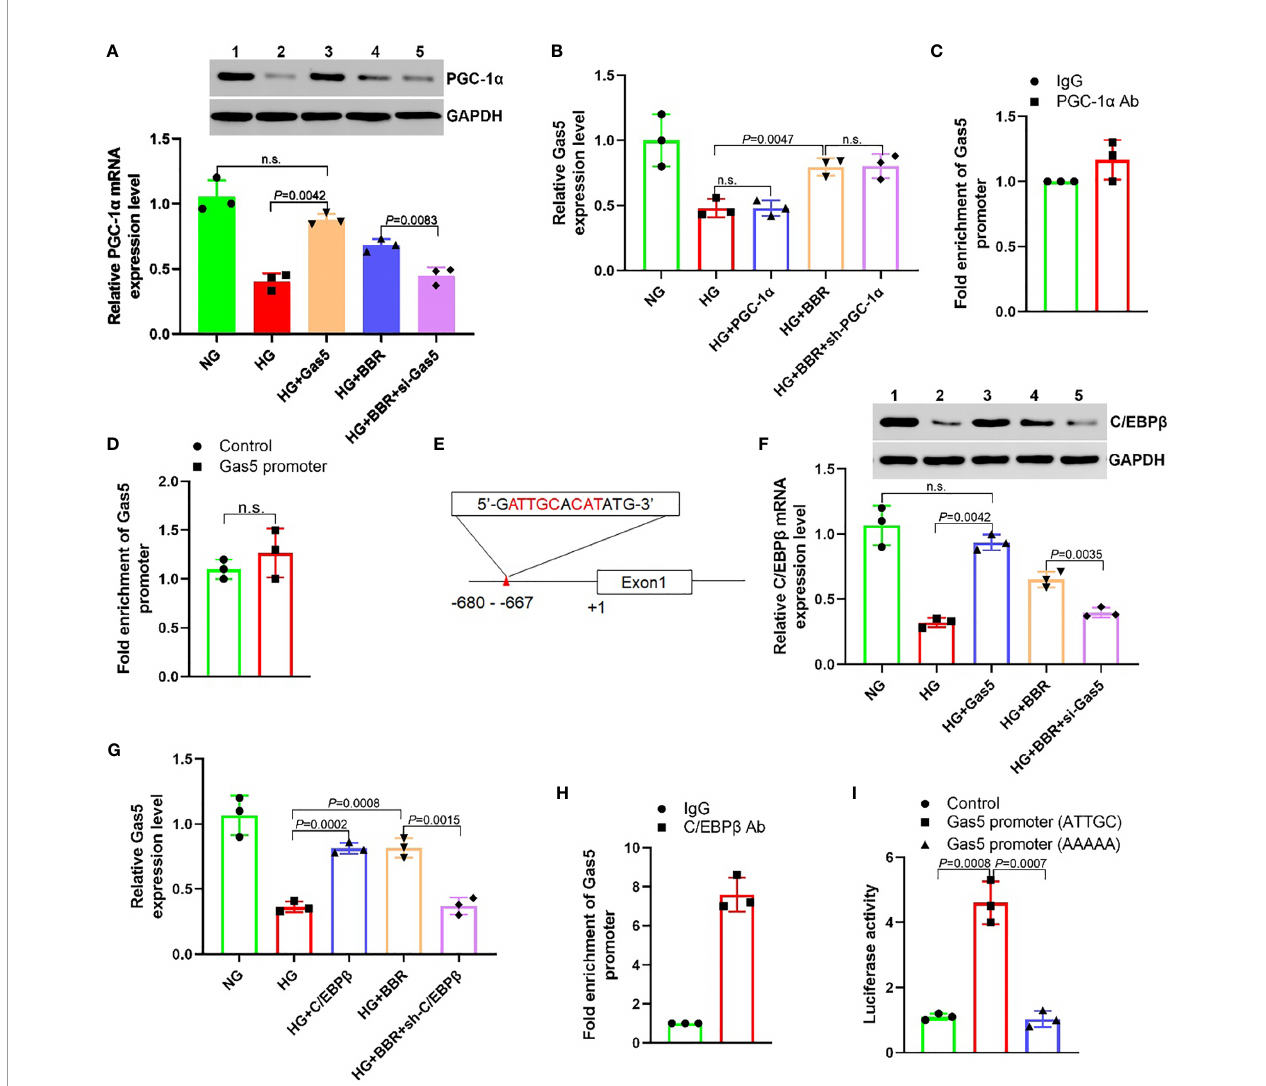
FIGURE 4 | BBR regulates the expression of Gas5 dependent on C/EBP b . (A) The effect of BBR and Gas5 on the PGC-1 a expression. (B) The effect of PGC- 1 a on the Gas5 expression. (C) Analysis of the effect of PGC-1 a on Gas5 promoter by ChIP-qPCR. (D) The effect of PGC-1 a on Gas5 promoter. (E) Schematic illustration of consensus C/EBP b responsive element in Gas5 gene promoter. (F) The effect of BBR and Gas5 on the C/EBP b expression. (G) The effect of C/EBP b on the Gas5 expression. (H) Analysis of the effect of C/EBP b on Gas5 promoter by ChIP-qPCR. (I) The effect of C/EBP b on Gas5 promoter. n.s., no signi fi